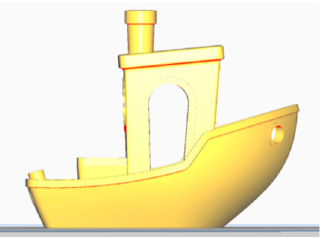
Figure 11. Model of a “Benchy” boat form *.stl file.